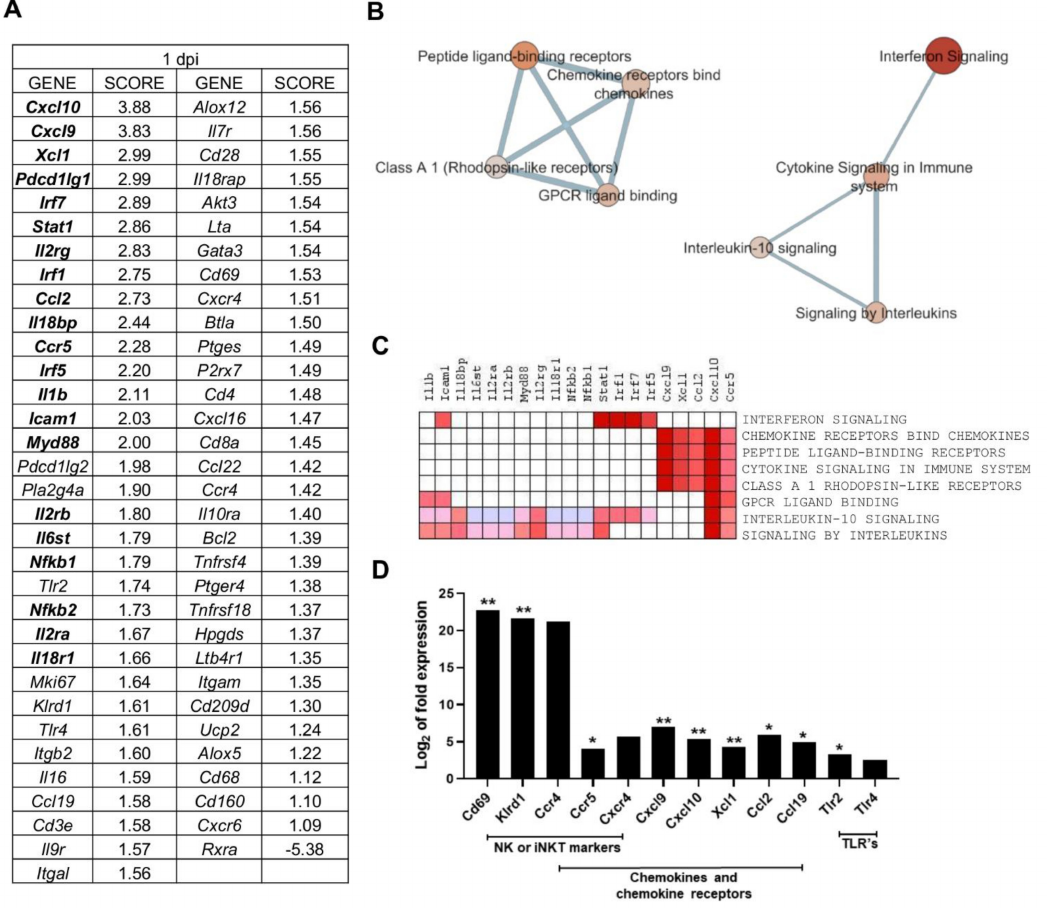
Figure 3. Multiple processes are activated in L. infantum infection in livers of BALB/c mice at 1-day post inoculation: ( A ) Ranked gene list generated in Gene Set Enrichment Analysis (GSEA) (using Principal Component 2-correlated genes to compare gene expression in 1 day p.i.-mice group vs. all other mice). Genes indicated in bold were involved in the core enrichment; ( B ) Enrichment Map with Principal Component 2 (PC2)-correlated genes. Parameters to filter these nodes/gene sets applied in Cytoscape: p -value < 0.05 and False Discovery Rate (FDR) < 0.25. Intensity of node color fill represents FDR value (more intense red color indicates lower FDR); node size corresponds to the Normalized Enrichment Score (NES) value. Thicker connection lines represent higher similarity coefficient between nodes; ( C ) Core enrichment of PC2-gene sets. The leading edge analysis was performed in GSEA with the gene sets enriched (with p -value < 0.05 and FDR < 0.25). The heat map shows the clustered genes in the leading edge subsets. Score values in the ranked gene list generated in GSEA are represented as colors, where the range of color (red, pink) shows the range of score values (high, moderate); ( D ) mRNA expression of genes at 1-day post infection expressed as Log 2 of expression fold-change. Statistically significant differences between non- infected (control) and infected animals are indicated (* p < 0.05; ** p < 0.01). Enrichment analysis showed that eight gene sets were significantly enriched at FDR < 25% and nominal p -value < 5% (Table 2). The interferon signaling pathway